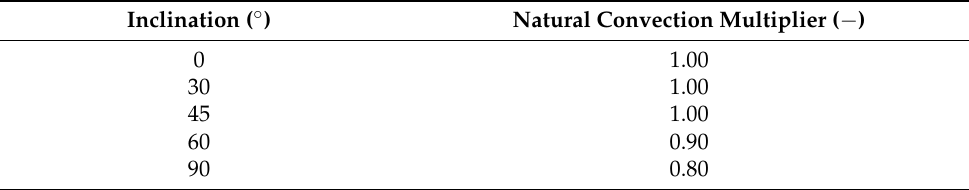
Table 3. Calibrated heat transfer coefficients for various inclinations.